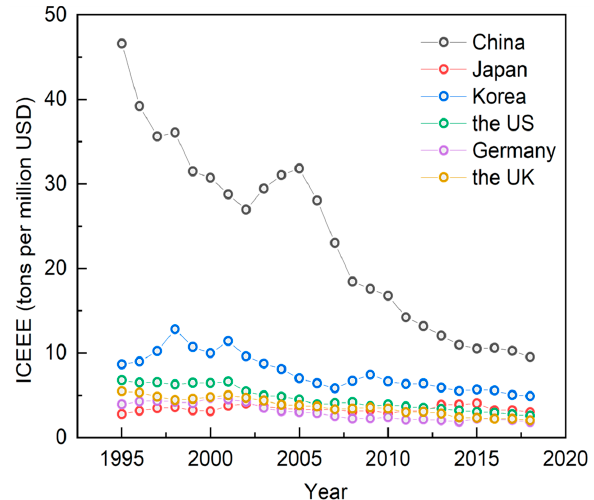
Figure 4. Trends in the ICEEE of manufacturing in major global economies, 1995–2018 (in tons per million USD). Data source: Authors’ calculations based on OECD database.